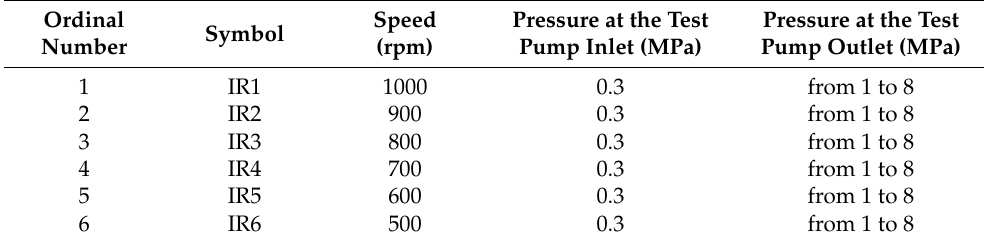
Table 2. Operating modes used during the experimental testing